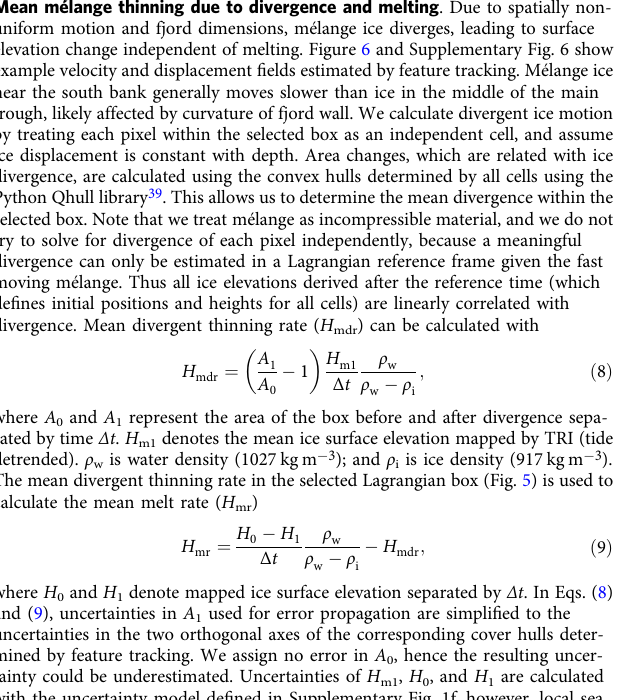
Fig. 3e. The amplitude and phase match tidal predictions well. Another method to derive elevation change from TRI measurements was fi rst described by Voytenko et al. 38 . This takes advantage of the TRI characteristic that displacement measurements are only sensitive in the LOS direction. Thus a point with ice fl ow perpendicular to the radar LOS direction should have zero displacement as seen by the radar, unless it has vertical motion (e.g., caused by tides). Point E in Supplementary Fig. 3b moves almost perpendicular to the LOS direction (within ±5 to 90°) 6 so its projection of displacement onto radar LOS should have minimal in fl uence on observed periodic signals. Assuming the TRI- observed displacement (grey dots in Supplementary Fig. 3f) was only caused by vertical motion (Supplementary Fig. 3c describes the geometry), we can calculate vertical motion by inversely projecting the integrated LOS displacements (black dots in Supplementary Fig. 3f) onto vertical direction using R D ver ¼ D los ; ð 7 Þ H r where D ver is integrated vertical displacement (tidal variation). R is slant range distance from the radar to the study point, ~2.8 km. H r is the height difference between the radar and the study point, ~190m. D los is integrated LOS displacement measure by TRI. These parameters are shown in Supplementary Fig. 3c. Red dots in Supplementary Fig. 3f show elevation time series (frequencies between 0.8 and 4 cycle-per day passed) from Eq. (7). The overall amplitude of these tidal estimates is signi fi cantly larger than the tidal model, and the phase difference is also larger than the extracted tides from elevation data shown in Supplementary Fig. 3e. We interpret these as side-to-side motion of ice in the mélange, which might be related to ocean currents 6 . Hence, the assumption that the TRI-observed LOS displacement at this location is only caused by vertical motion is invalid. However, this method may still be useful to provide tidal information in the absence of other data 38 . In addition, this method requires only one receiving